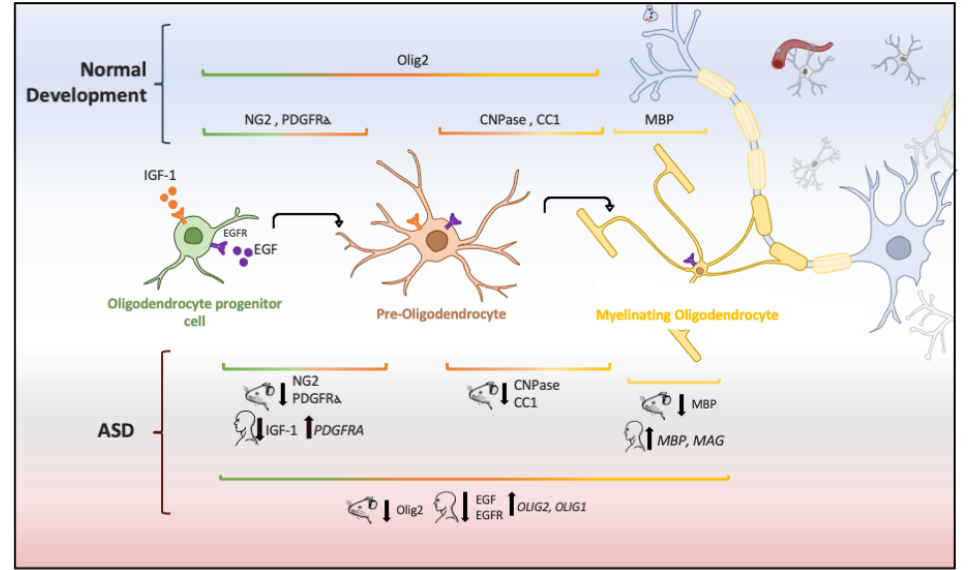
Figure 2. Oligodendrocyte lineage and molecular markers (genes or proteins) expressed under physiological and ASD conditions. Each human and mouse illustration indicates whether the molecular abnormality was found in clinical or experimental conditions [29,55,56,121–124].